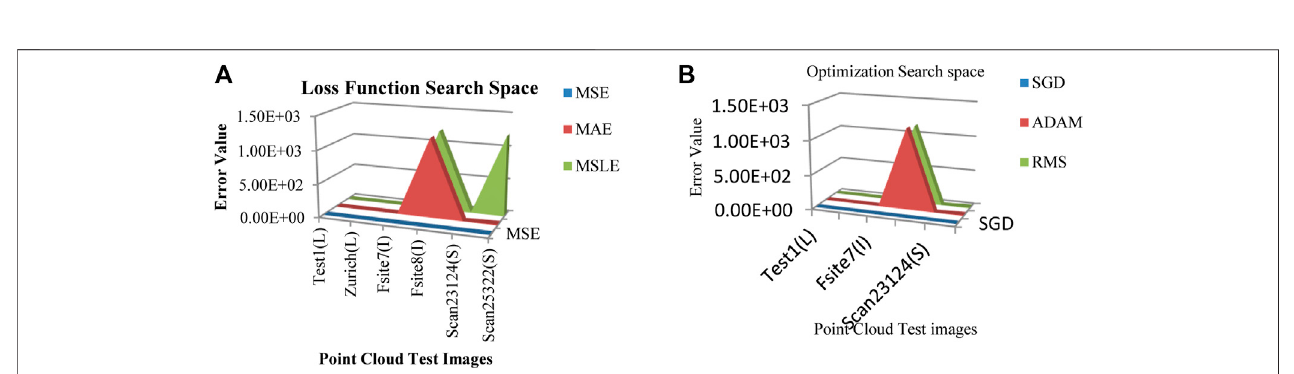
FIGURE 4 | (A) Loss function Search Space (B) Optimizer function Search